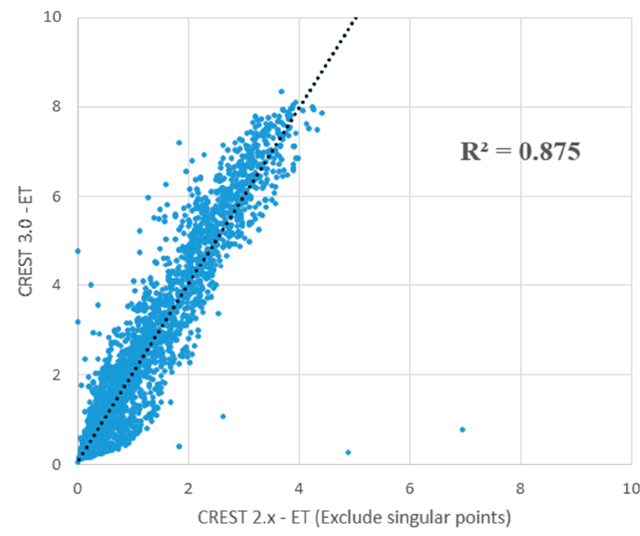
Figure 10. Scatter plot of simulated evapotranspiration of CREST 2.x (excluding singular points) and 3.0 models.